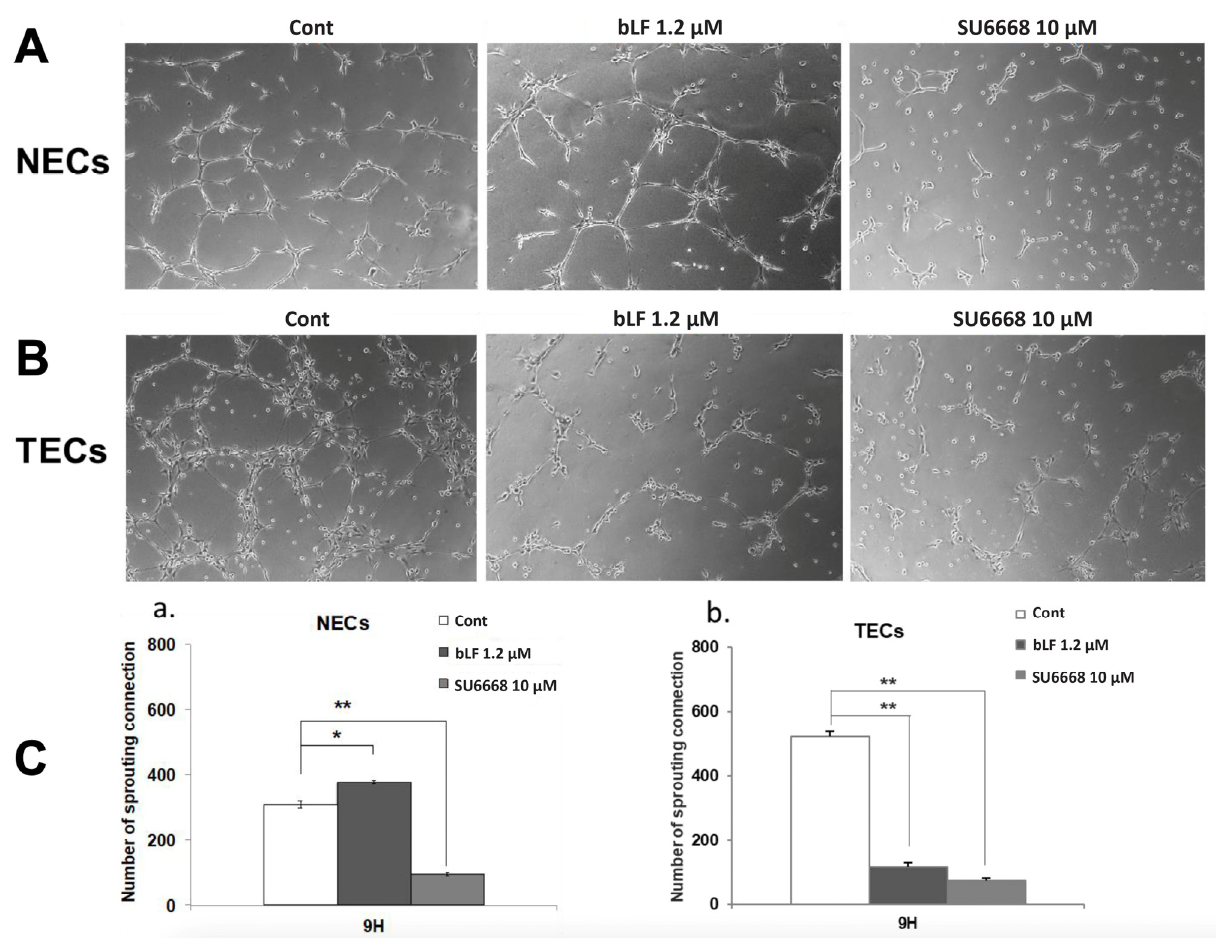
Figure 2. Effect of bLF on tube formation of NECs and TECs. Tube formation assay was conducted in the presence of 1.2 µM bLF or 10 µM SU6668. In vitro assay findings, ( A ) NECs and ( B ) TECs. ( C ) Number of tube junctions in ( a ) NECs and ( b ) TECs. Data represent the mean ± standard deviation (SD) of three-independent experiments, each performed in triplicate. Statistical significances were determined by one-way analysis of variance (ANOVA). * p < 0.05, ** p < 0.01.